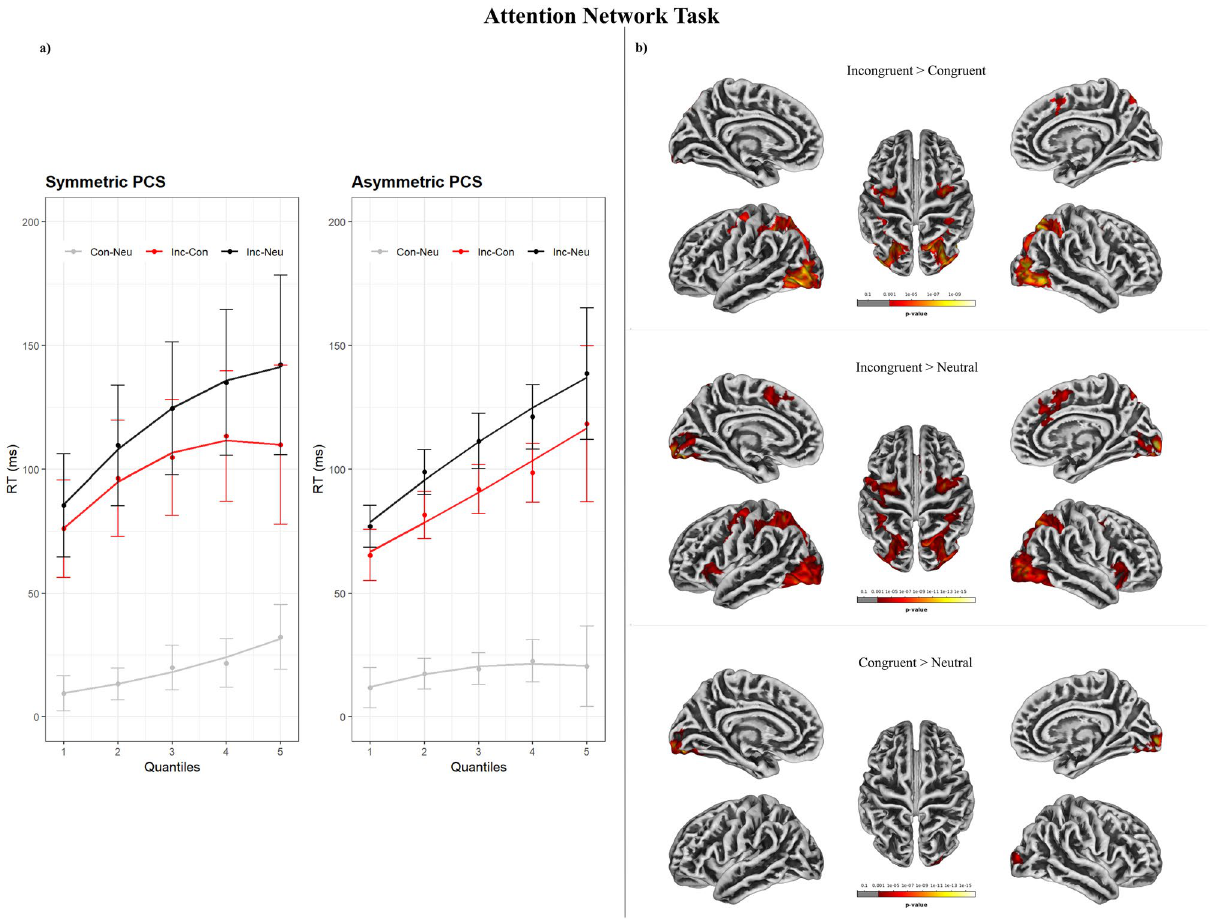
Figure 1. ( a ) Delta plots of the effects detected in the Attentional Network Task (ANT), as a function of quantiles. ( b ) Brain activity during the ANT. Significant results are shown at cluster level FWE-corrected for multiple comparisons p-value < 0.05, and vertex level uncorrected p-value < 0.001. Inc Incongruent, Con Congruent, Neu